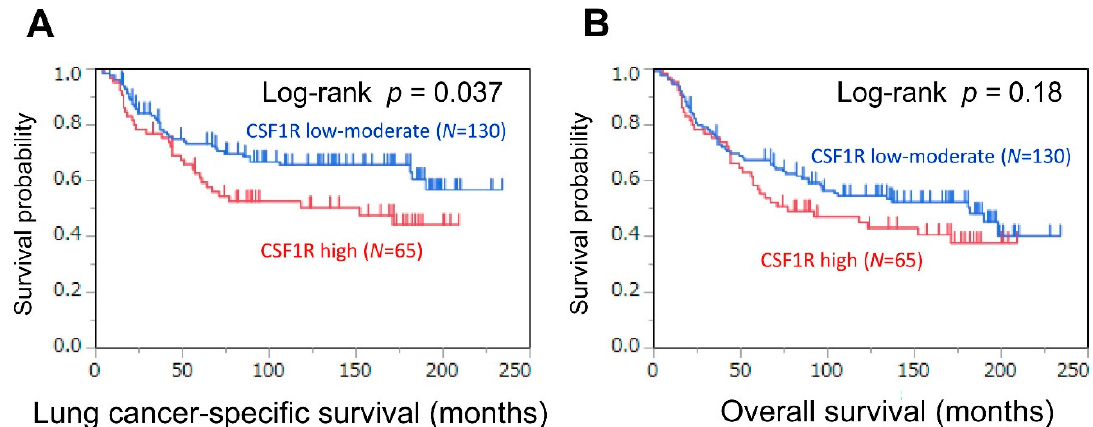
Figure 2. Kaplan–Meier curves for lung cancer-specific ( A ) and overall ( B ) survival, according to CSF1R expression status of tumor-associated macrophages (low–moderate vs. high), in lung adenocarcinoma patients.